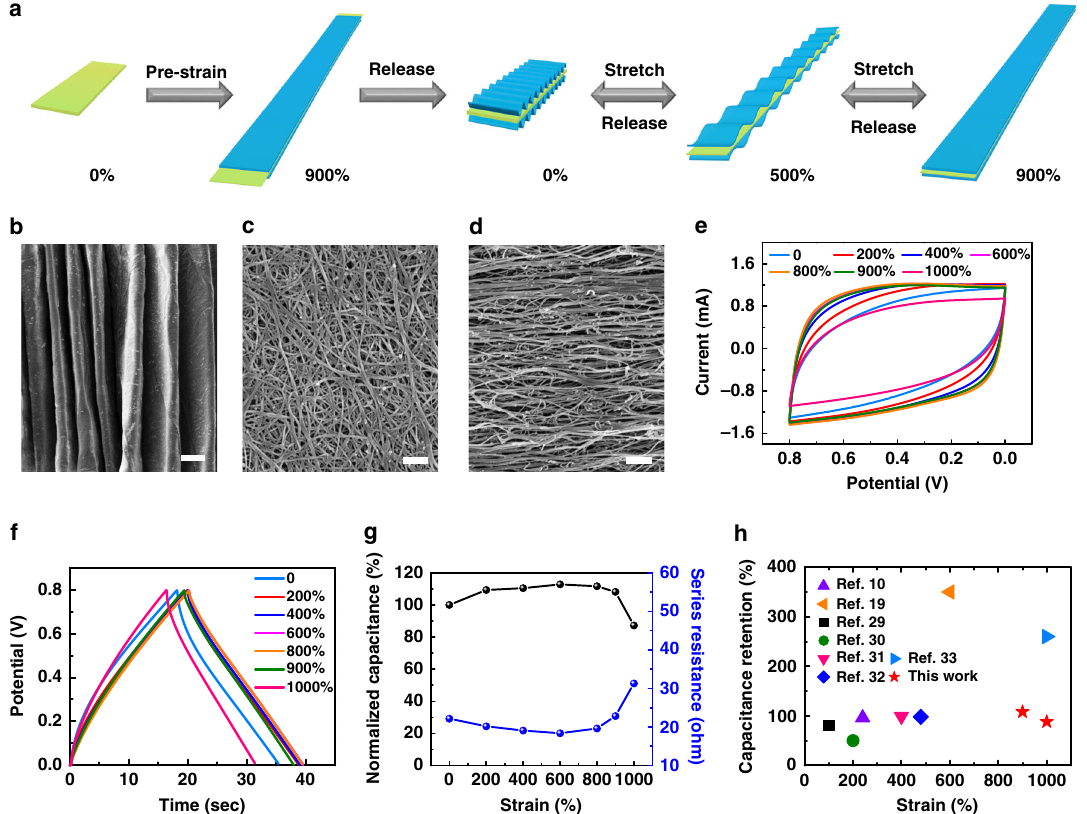
Fig. 2 Fabrication and properties of the stretchable supercapacitor devices. a Schematic for fabrication of a stretchable supercapacitor by using the hydrogel as electrolyte and CNT fi lms as electrodes through a pre-strain/release process. b – d Scanning electron microscopy (SEM) images of the formed wrinkled CNTs ( b , scale bar: 200 μ m) in a supercapacitor being re-stretched to strains of 900% ( c , scale bar: 500 nm) and 1000% ( d , scale bar: 500 nm). e – g Cyclic voltammetry (CV) curves ( e ), galvanostatic charge/discharge (GCD) curves ( f ) and normalized electrochemical performance ( g ) of a supercapacitor being stretched from 0 to 1000% strain. h Comparison of capacitance retention and stretchability of our stretchable supercapacitors